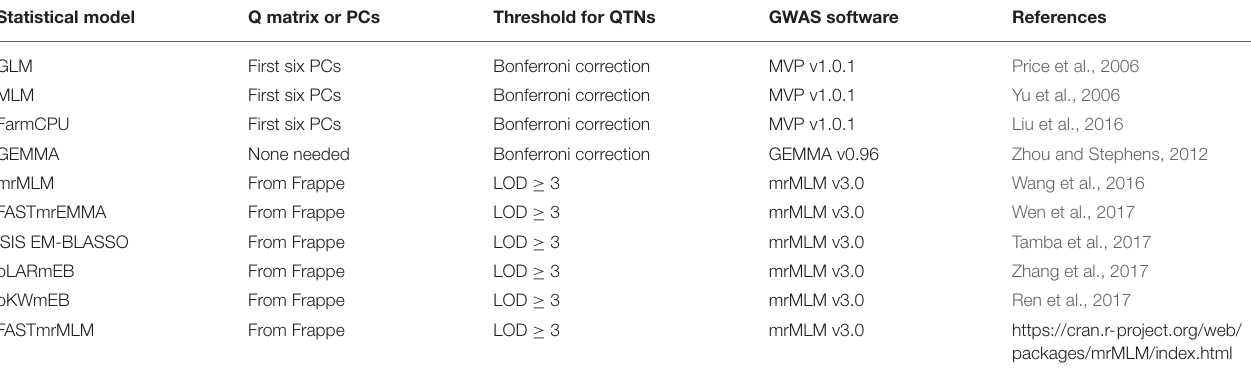
TABLE 2 | Statistical methods used for